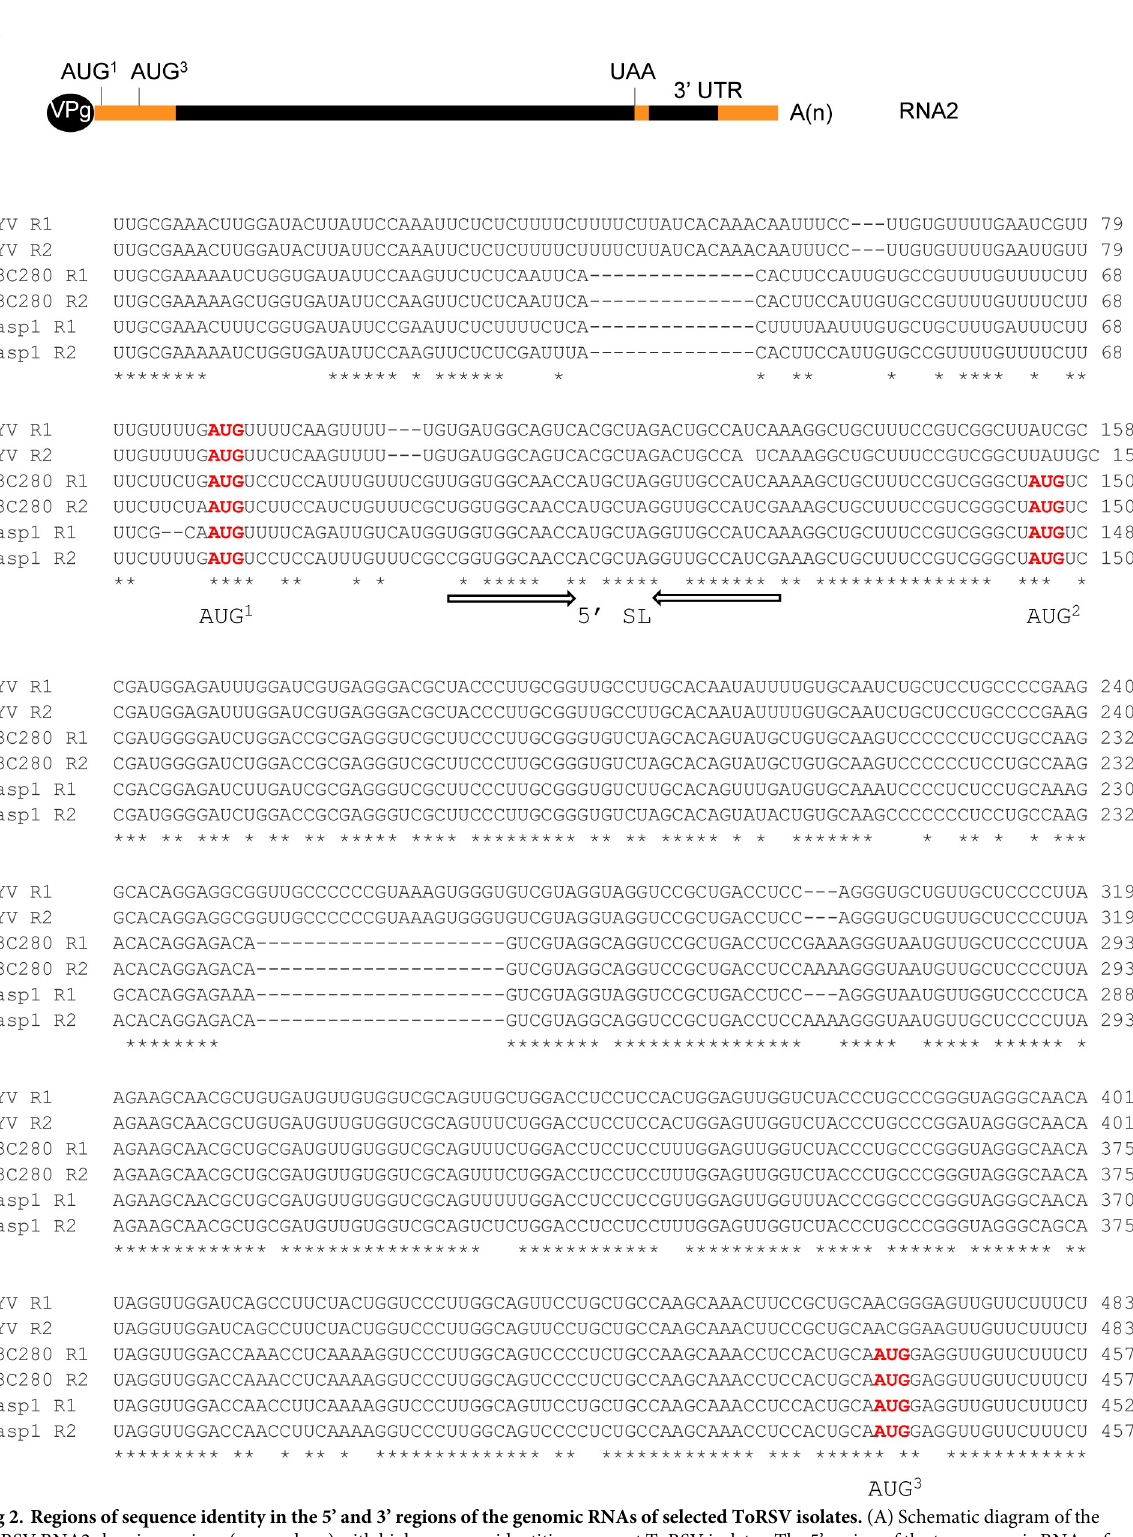
Fig 2. Regions of sequence identity in the 5’ and 3’ regions of the genomic RNAs of selected ToRSV isolates. (A) Schematic diagram of the ToRSV RNA2 showing regions (orange bars) with high sequence identities amongst ToRSV isolates. The 5’ region of the two genomic RNAs of many ToRSV isolates are nearly identical in the first 900 nts. The first 150 nts and last 650 nts of the 3’ UTRs of the two genomic RNAs are also